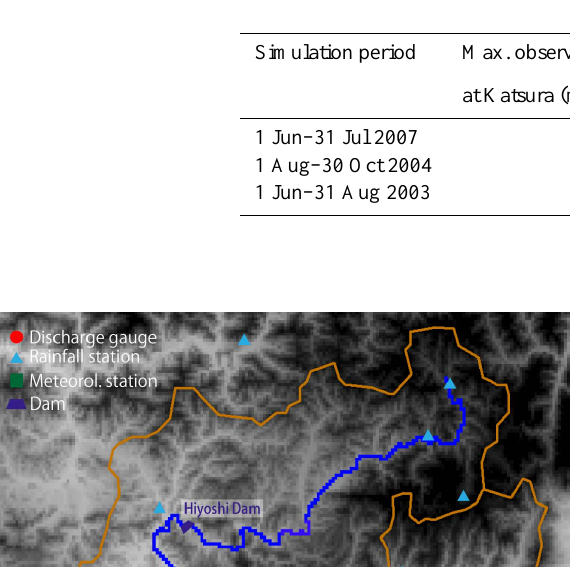
Table 1. Simulation periods and observed flow.